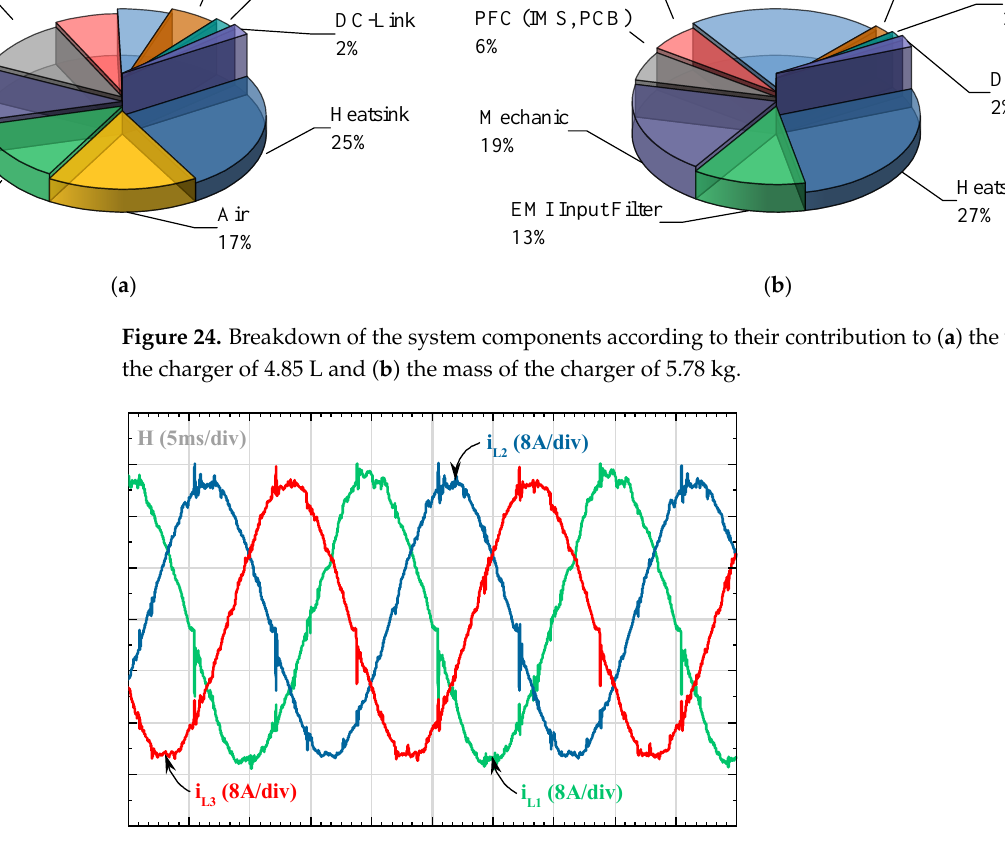
Figure 24. Breakdown of the system components according to their contribution to ( a ) the volume